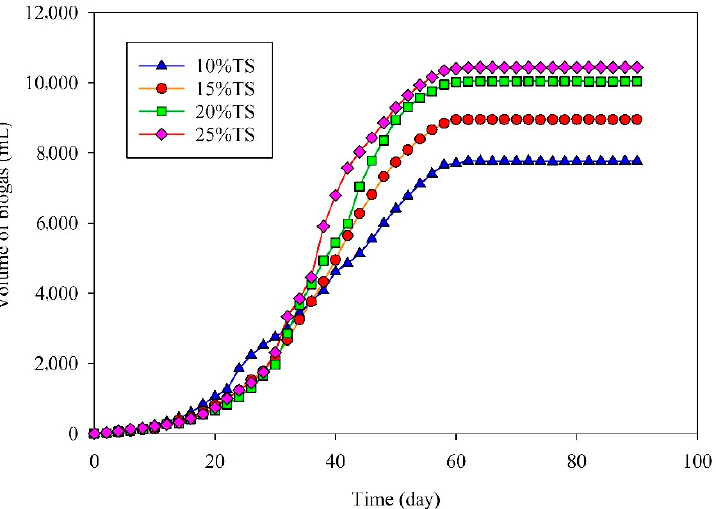
Figure 4. Effect of different percentages of total solids (TS) on delignified C/N 25 (g/g) ratio biogas volume accumulation.